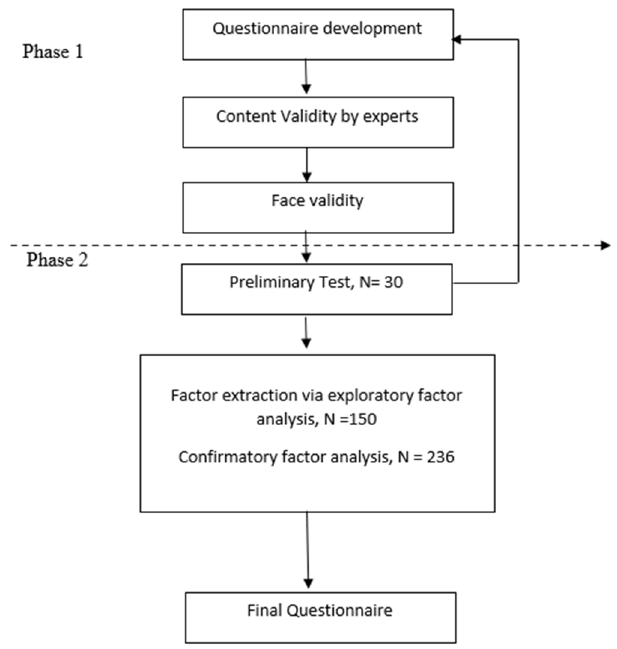
Figure 1. Flowchart of the development and validation process.